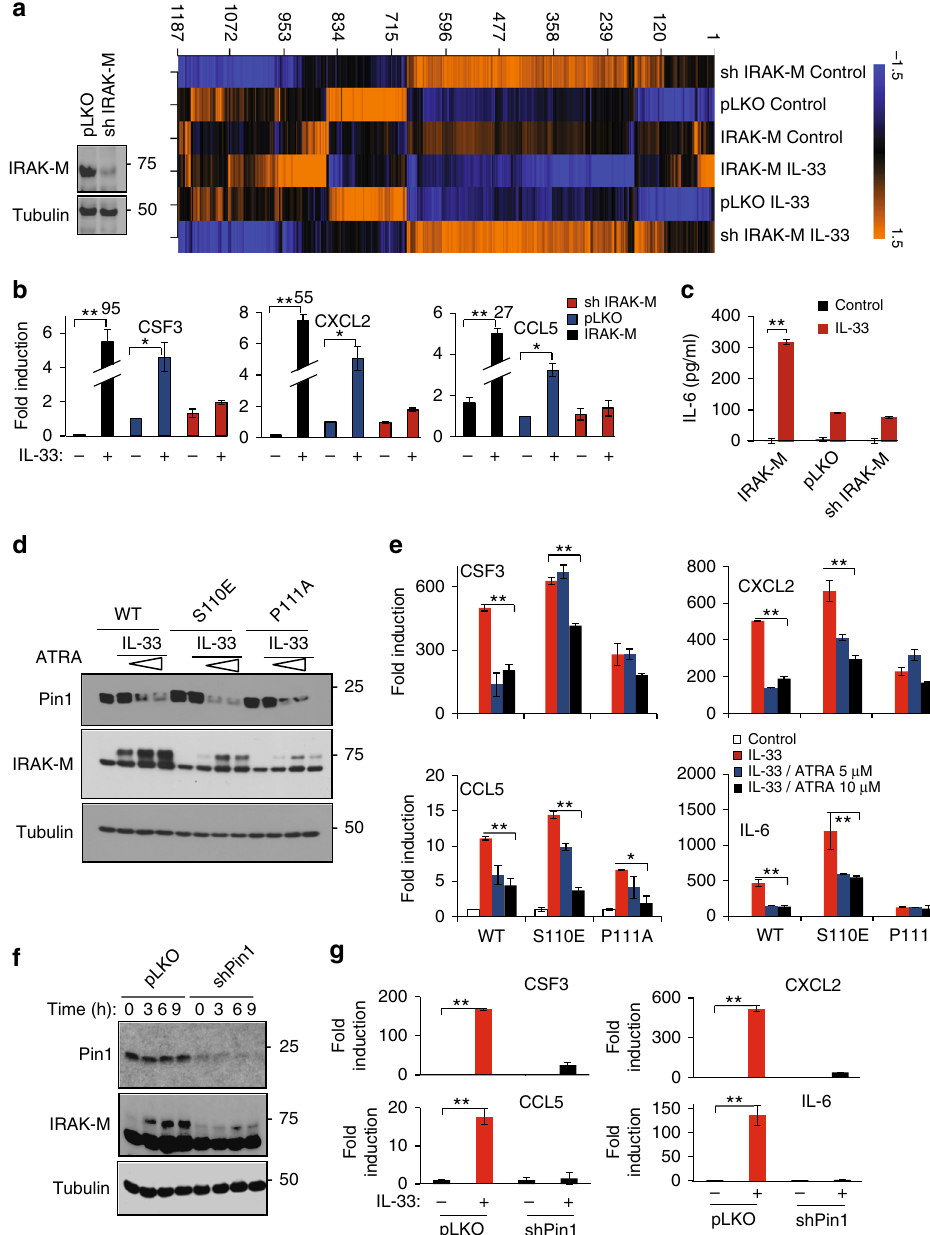
Fig. 5 IRAK-M is necessary for Il6 , Csf3 , Cxcl2 and Ccl5 expression in dendritic cells upon IL-33 induction. a Western blot shows IRAK-M levels in shIRAK-M expressing DC2.4 cells. Right panel shows heat map showing expression levels of different genes according to the affymetrix gene expression pro fi ling analysis. b qRT-PCR analysis for expression of the indicated genes normalized to actin. The numbers over bars (95, 55 and 27) indicate the folds of induction of target genes in the presence vs absence of IL-33 in the sh IRAK-M group. c Quanti fi cation of IL-6 release measured by ELISA. d IRAK-M, IRAK- M S110E or IRAK-M P111A stably expressing DC2.4 cells were either treated or not with IL-33. Also as indicated, some cells were pretreated for 3 days with 5 μ M or 10 μ M of ATRA before IL-33 induction. e Relative gene expression of Il6 , Csf3 , Cxcl2 and Ccl5 in the different samples as in d normalized to actin. f IRAK-M was stably expressed in pLKO or TET on shPin1 expressing cells, followed by induction with IL-33, before western blot to examine protein expression of IRAK-M, PIN1 and tubulin as well as g qRT-PCR to determine the relative gene expression for Il6 , Csf3 , Cxcl2 and Ccl5 in the different samples. The data were analyzed by a Student ’ s two-tailed t test and the values are reported as mean ± standard errors of the means (SEM). *- statistical signi fi cance ( P < 0.05), **- signi fi cance ( P < pS110P motif, IRAK-M may dissociate from the Myddosome, leading to its nuclear localization and protein stability.